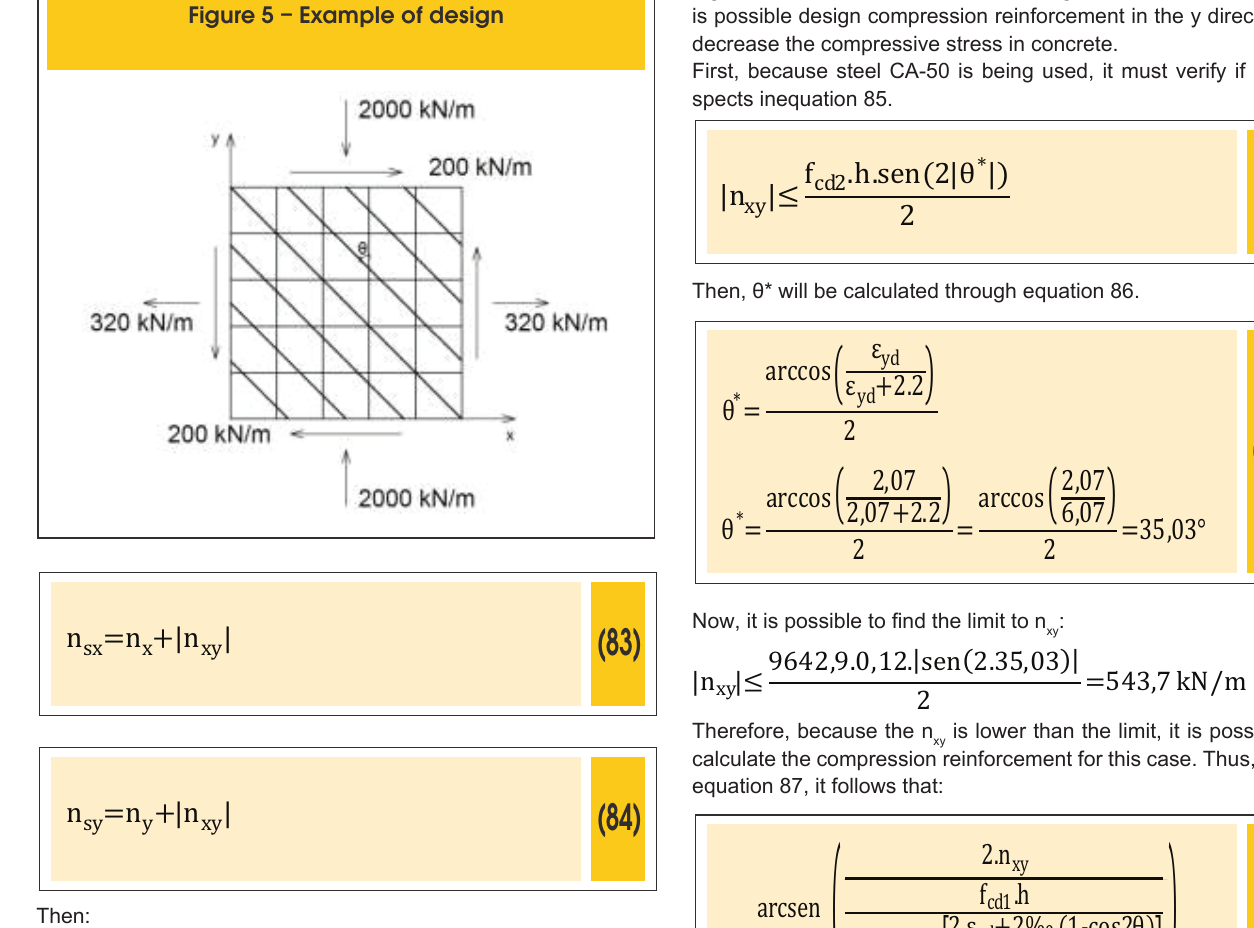
Figure 5 – Example of